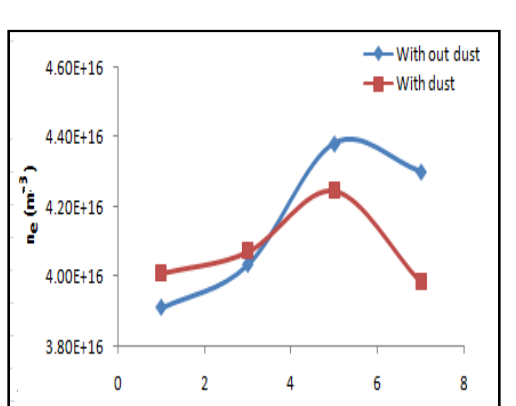
Fig.10: The electron temperature as a function of the Diameter position at different distances of the probe.